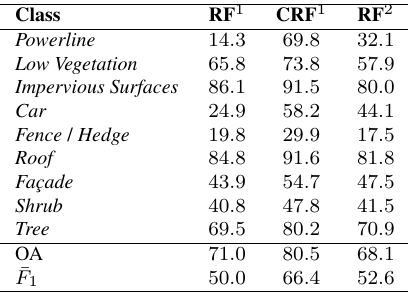
Table 6. Classwise F 1 -scores (in %) as well as OA and ¯ F 1 (in %) for the Vaihingen Dataset ( 1 result presented by Steinsiek et